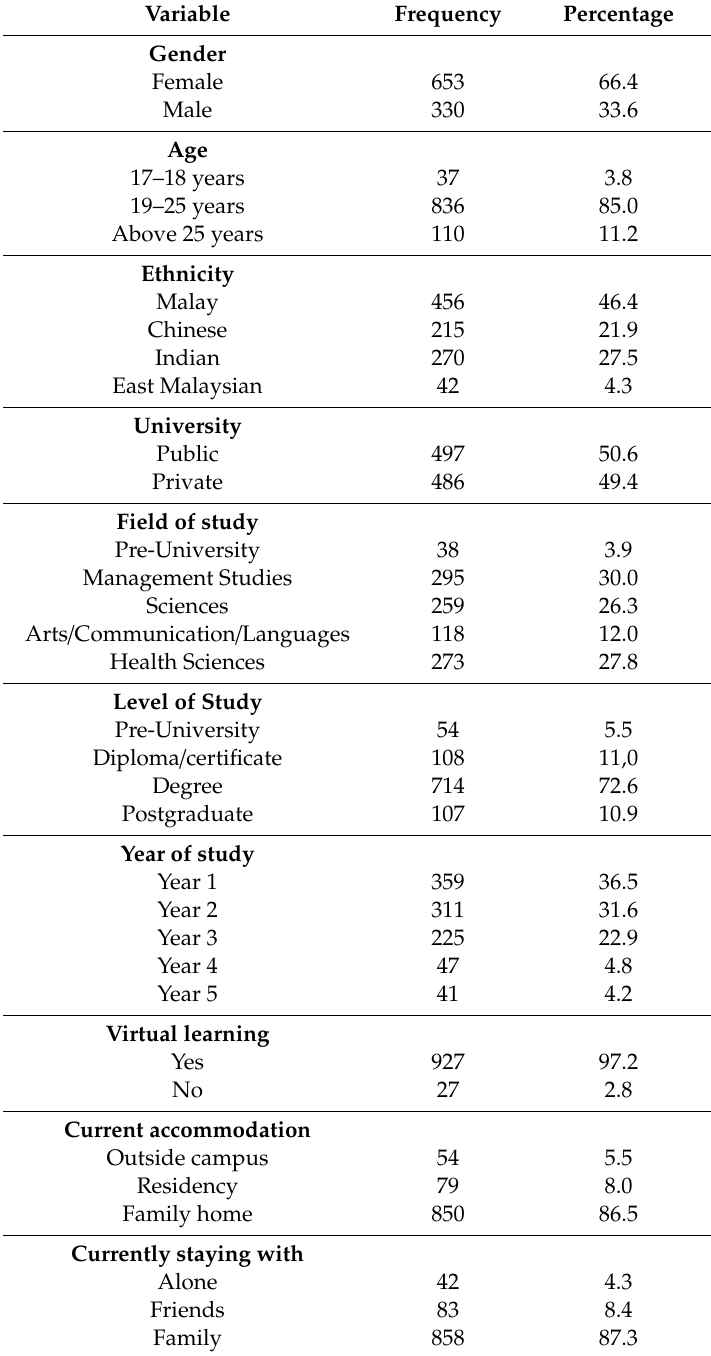
Table 1. Demographic characteristics of the